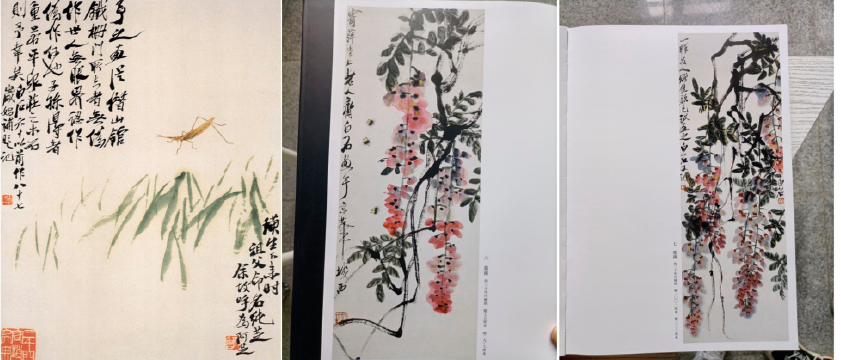
Figure 8. Examples of high-definition calligraphy database.